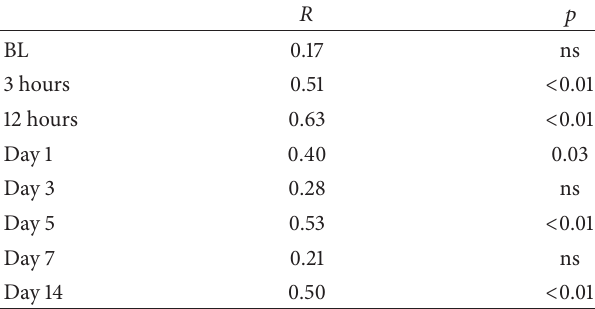
Table 2: Correlation between levels of dsDNA and nucleosomes at corresponding time points in the total study population (𝑛 = 30)